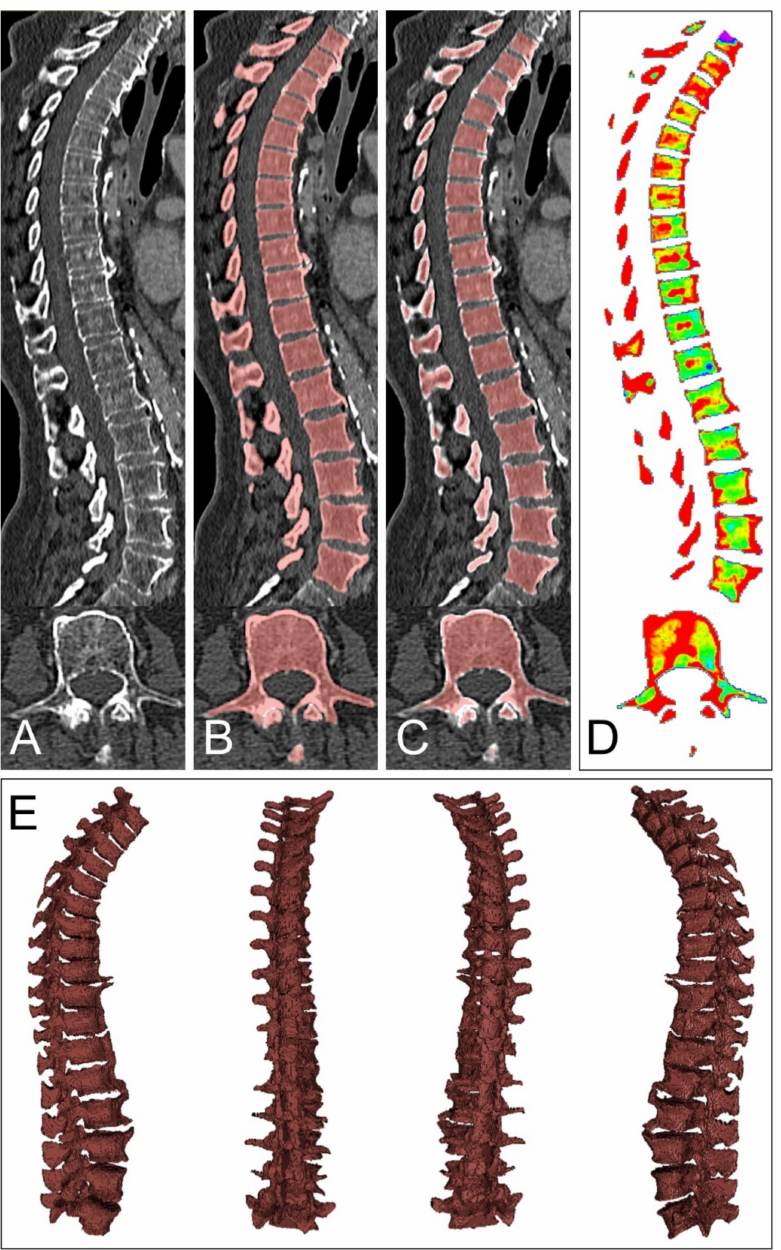
Figure 1. Volumetric assessment of bone marrow attenuation. Data assessment in our study was achieved by a pretrained convolutional neuronal network and did not require specific user interaction. Axial computed tomography slices served as input to the neuronal network by Payer et al. ( A ). After automated segmentation, excess vertebrae above 17, counting from the most bottom one, were excluded ( B ). Consecutively, the established volume of interest (VOI) was narrowed at each margin by 3 mm, which aimed to partially exclude the bordering cortical bone but spare the bone marrow space ( C ). Lastly, the VOI was transferred to the virtual non-calcium postprocessed data at three different calcium suppression levels (( D ), only maximum calcium suppression shown), resulting in volumetric bone marrow attenuation data ( E ). Histograms of bone marrow attenuation were extracted for further